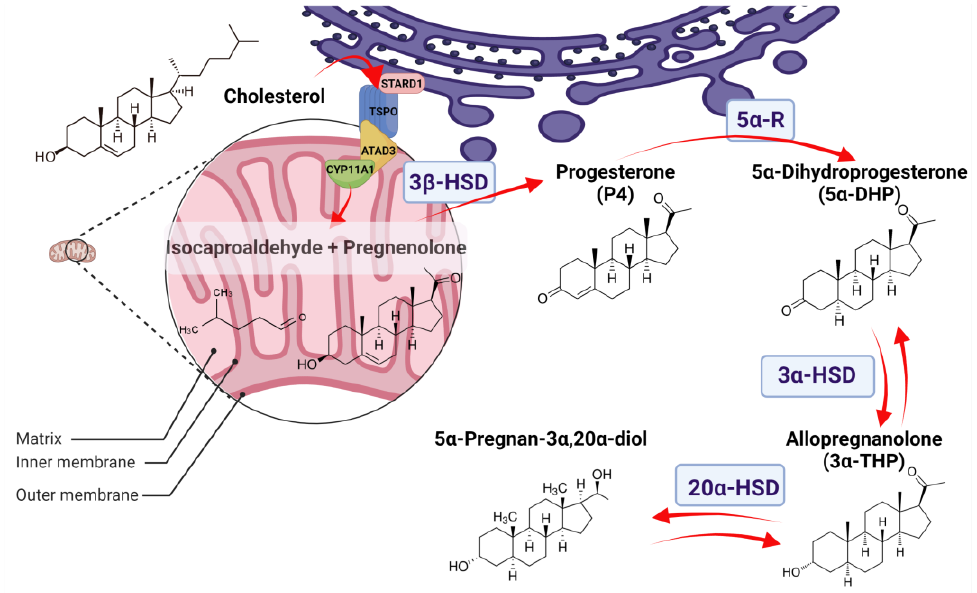
Figure 1. Allopregnanolone (3 α - THP) synthesis in normal tissues. The 3α -THP synthesis begins when cholesterol is imported from the cytoplasm or the endoplasmic reticulum (purple) to the mitochondrion (pink) by a protein complex formed by the steroidogenic acute regulatory protein (StARD1), the translocator protein of 18 kDa (TSPO), and the ATPase family AAA-domain-containing protein 3A (ATAD3A), which are in close contact with the P450 side chain cleavage (CYP11A1). CYP11A1, at the inner mitochondrial membrane, catalyzes the cleavage of cholesterol to pregnenolone and isocaproaldehyde. Pregnenolone, either in the inner mitochondrial membrane or at the endoplasmic reticulum, is then isomerized to progesterone (P4) by the 3β -hydroxysteroid dehydrogenase (3β - HSD). At the endoplasmic reticulum, P4 is irreversibly reduced to 5α -Dihydroprogesterone (5α -DHP) by the isozymes 5 α -reductases (5 α - R). At the cytoplasm, 5α -DHP is reversibly reduced to allopregnanolone (3 α - THP) by 3α -hydroxysteroid dehydrogenases (3 α -HSD) coded by the AKR1C1-4 genes. Finally, 3 α -THP can be a substrate of the 20α -hydroxysteroid dehydrogenase (20 α - HSD), coded by AKR1C1, to produce 5α -Pregnan- 3α,20α -diol.